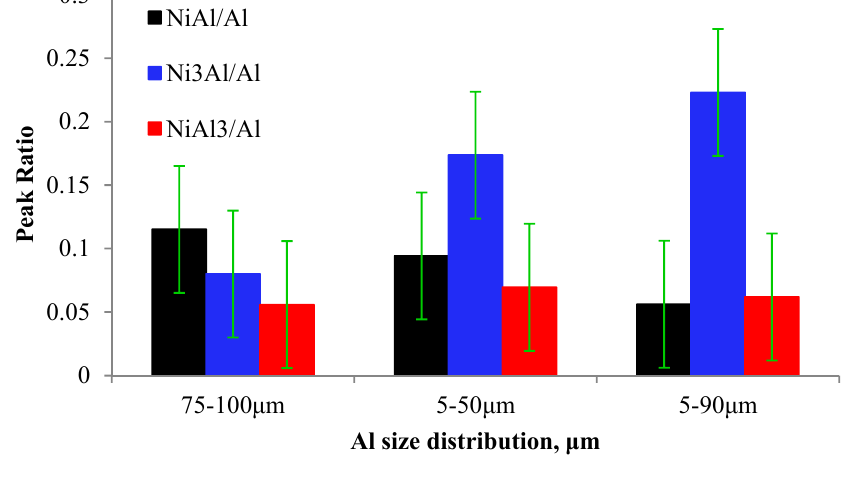
Figure 6. Influence of particle size on the yield of Ni-Al